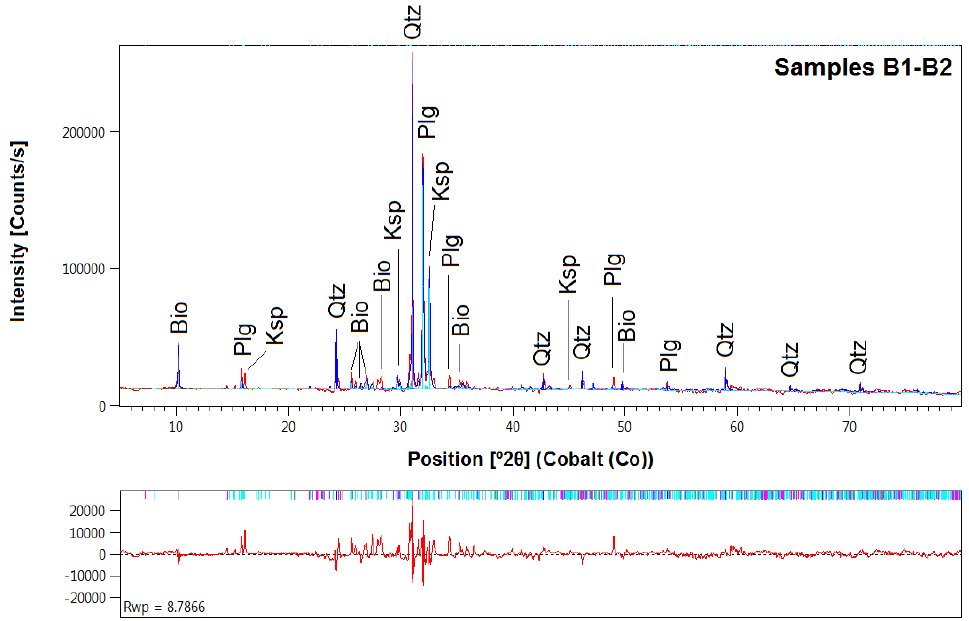
Figure 5. X-ray diffraction pattern of the samples B1–B2. Qtz = quartz; Plg = plagioclase; Ksp = K-feldspar; Bio = biotite. Observed spectra (red line), fitted spectra (blue solid line), difference plot (below spectra), and Bragg peak positions (tick marks above difference plot) are shown. The weighted R-factor, Rwp, was calculated using the observed and calculated intensities in the powder diffraction patterns. Table 1. Mean mineralogical composition of the bulk rock samples. Standard deviation in parenthesis.